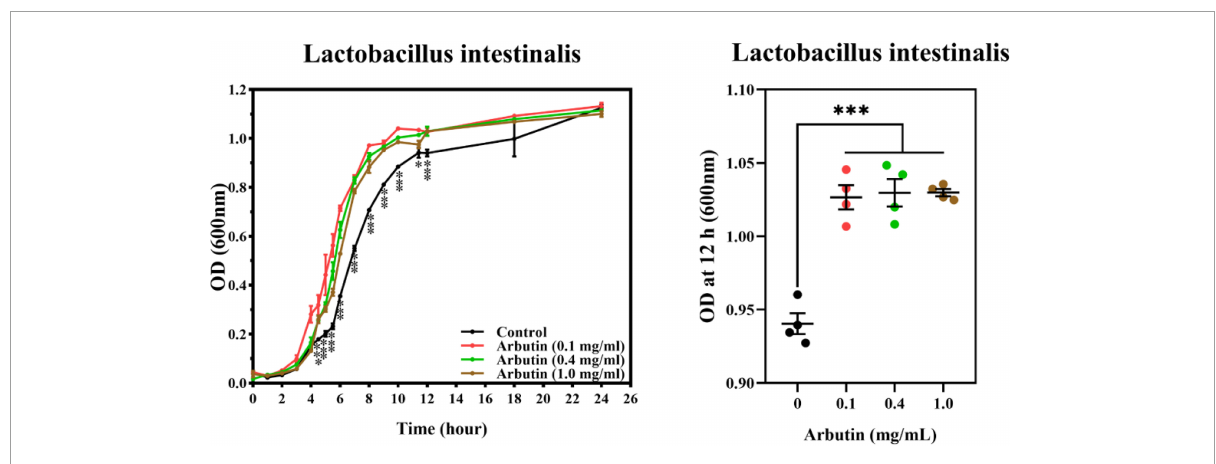
FIGURE8 Arbutin promotes the growth of Lactobacillus intestinalis in vitro . Arbutin and L. intestinalis were co-cultured and determined the OD value at 0–24 h. Differences were assessed by t -test and denoted as follows: ∗ P < 0.05, ∗∗∗ P <